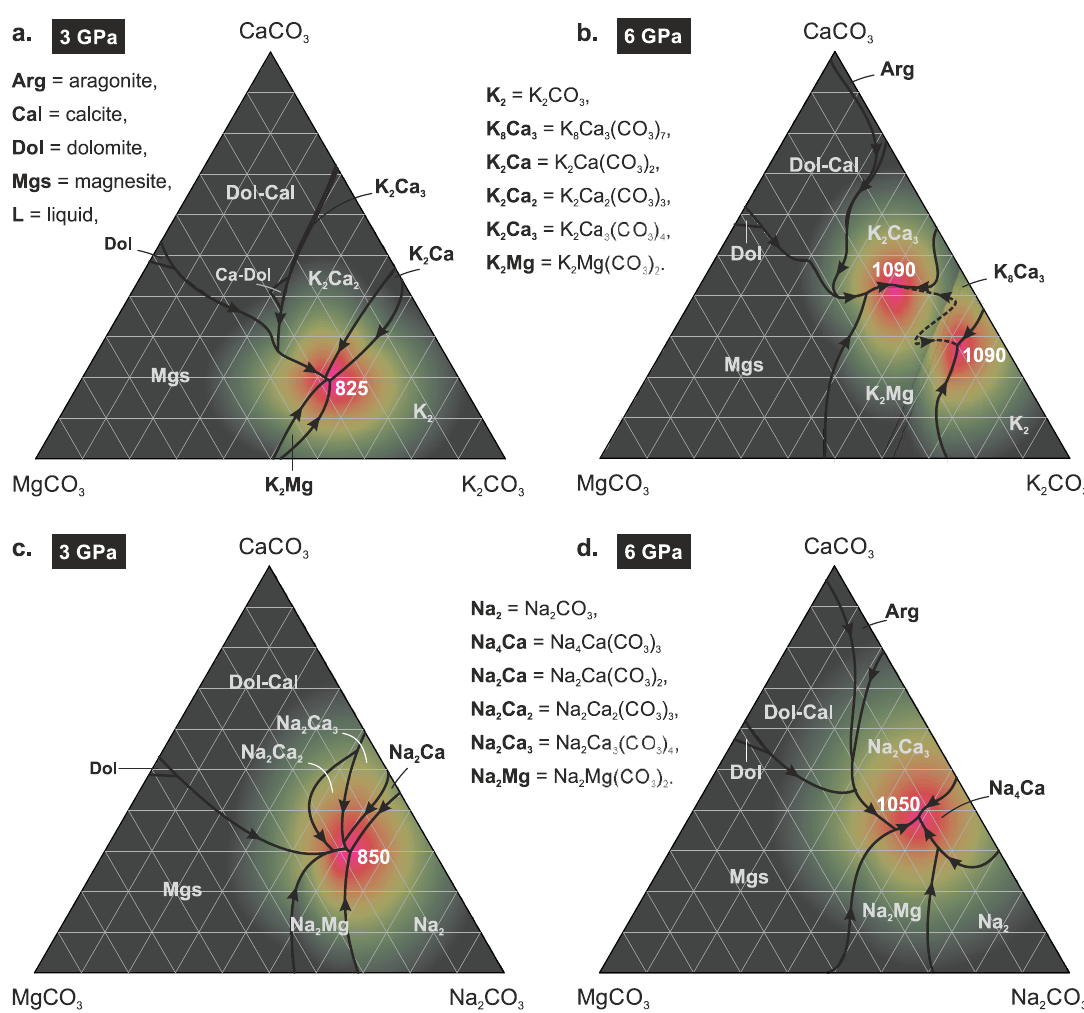
Figure 8. The diagrams illustrating primary crystallization regions and ternary eutectics in the system K 2 CO 3 – CaCO 3 – MgCO 3 at 3 GPa ( a ) [37] and at 6 GPa ( b ) (this study) and in the system Na 2 CO 3 – CaCO 3 – MgCO 3 at 3 GPa ( c ) [45] and at 6 GPa ( d ) [44]. Na 2 — Na 2 CO 3 , Na 2 Ca 2 — Na 2 Ca 2 (CO 3 ) 3 , Na 2 Ca 3 – Na 2 Ca 3 (CO 3 ) 4 , Na 2 Mg — Na 2 Mg(CO 3 ) 2 , see the Nomenclature section for other abbreviations.